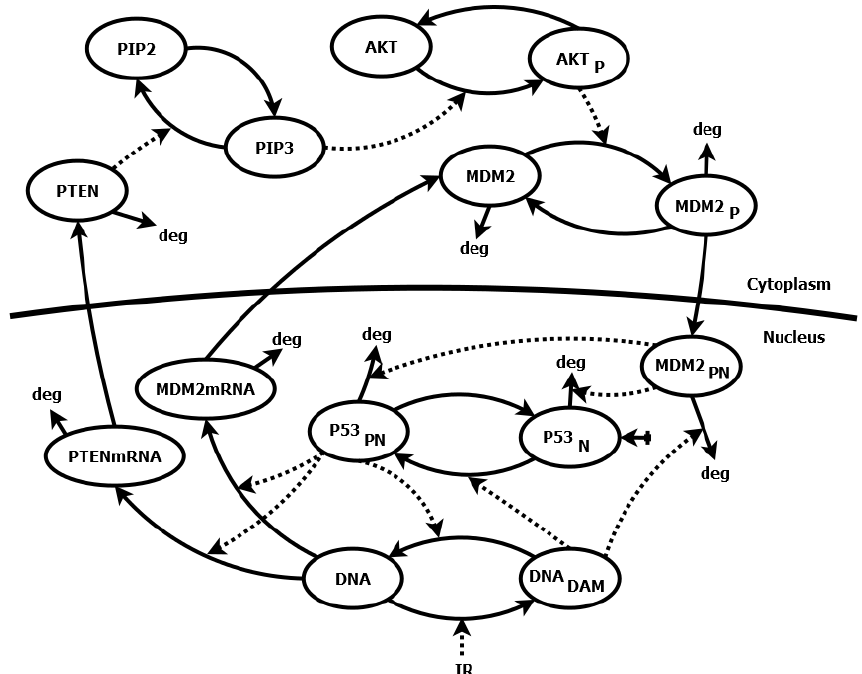
Figure 1. Schematic diagram of the p53 signaling pathway model [32]. The model involves two- compartmental kinetics of p53 protein, its primary inhibitor Mdm2, phosphatase PTEN, phos- phatidylinositol 3-phosphate (PIP3) and Akt kinase and is activated by IR radiation, which leads to DNA damage ( DNA DAM ). The N index stands for nuclear concentrations and P for phosphorylated molecules. Solid lines represent direct interactions in the model, such as production, degradation (deg) or state change (e.g., phosphorylated/nonphosphorylated) of selected molecules. Dashed lines represent indirect interactions, such as the catalysis of reactions or regulation of gene